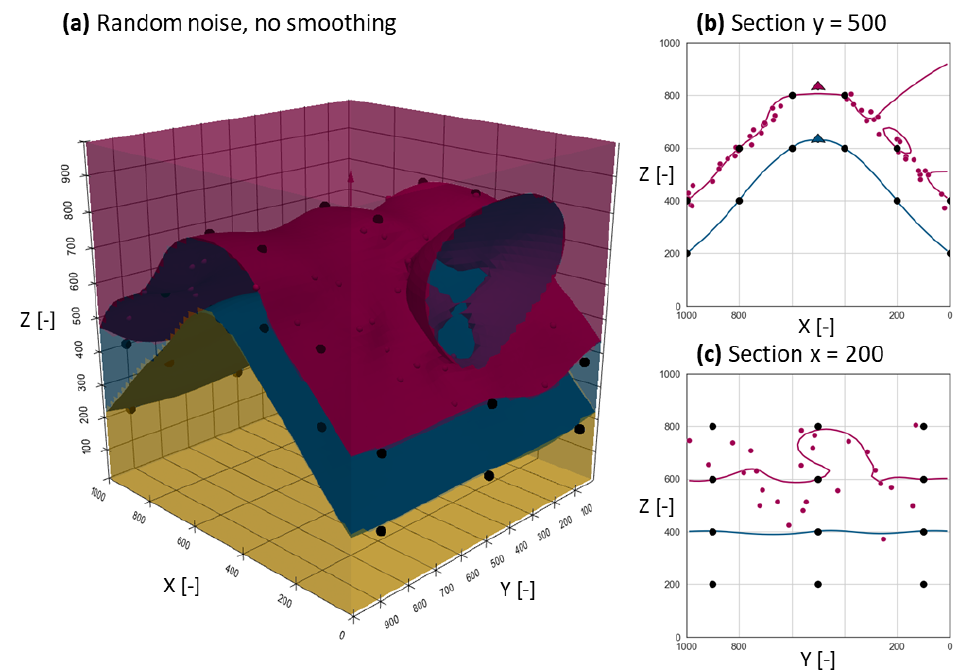
Figure 6. Geomodel of a folded unit. 50 noisy data points were added to the data of model in Figure 5. No smoothing was applied. ( a ) 3D model view. ( b ) Section at y = 500. ( c ) Section at x = 200. Note that input data are projected on section